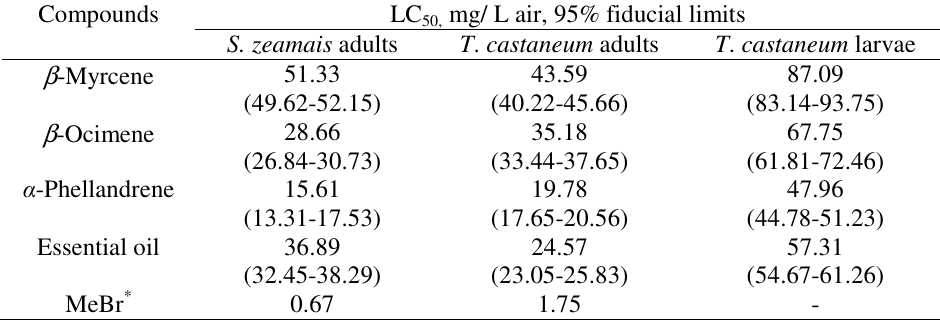
LC mg/ L air, 95% fiducial limits 50,